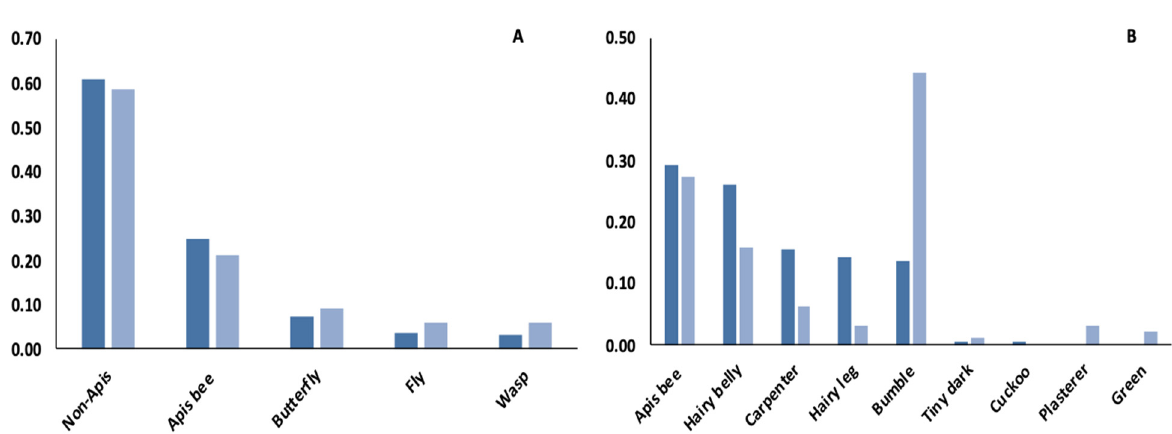
Figure 2. Performance-based Knowledge Gains-Insect Survey. Mean proportion of flower-visiting insects observed by experts (dark) and students (light) during a post-course, paired, insect survey at the Lady Bird Johnson Wildflower Center. Proportional abundance of ( A ) flower-visiting insect groups and ( B ) bee groups (see Supplementary Table S4).